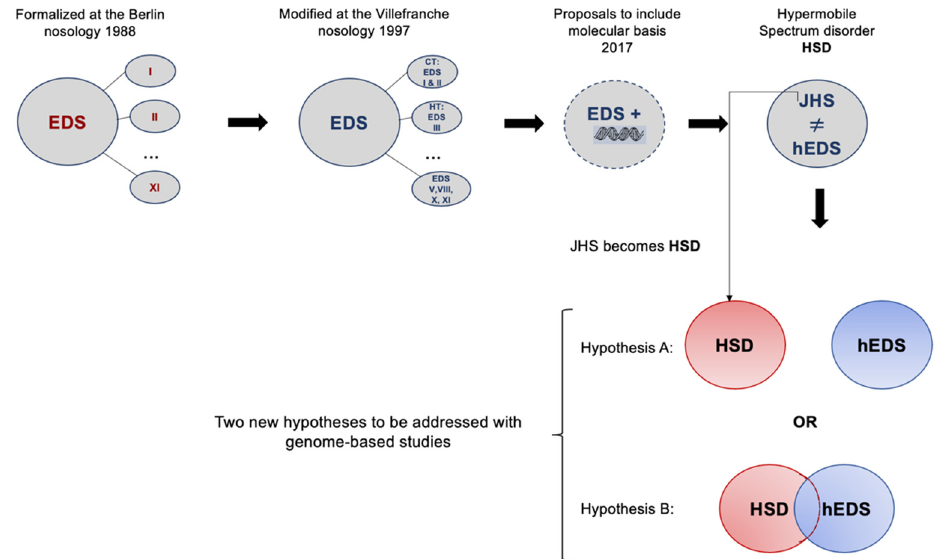
Figure 1. The continuous struggle to characterize joint hypermobility from 1998 to the current nosology established in 2017, in which two phenotypes are recognized. Hypothesis A identifies two diseases that have overlapping symptoms but are genetically different, while Hypothesis B presents two diseases with overlapping symptoms and common genetic